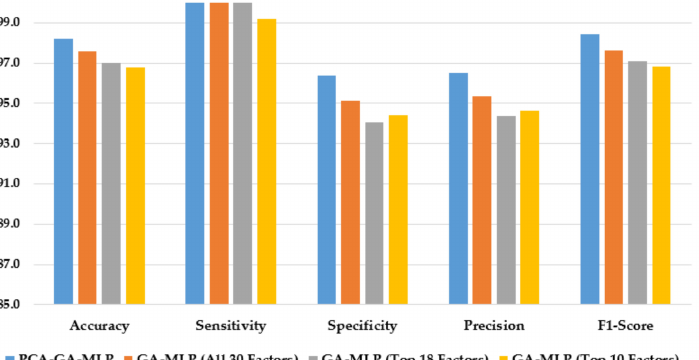
Figure 3. Comparison of the proposed method using four feature selection methods to diagnose